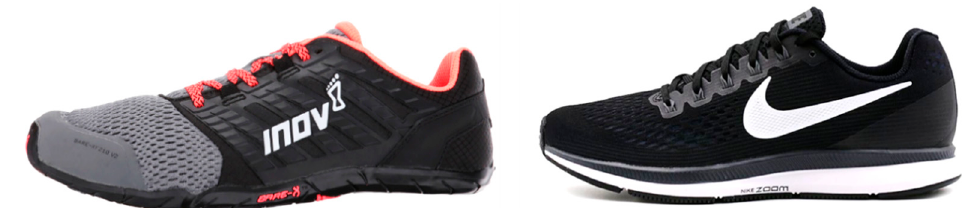
Figure 1. Shoes used in the experiment. Minimalist shoe: INOV-8 Bare-XF 210 V2 ( left ). Cushioned shoe: Nike Air Zoom Pegasus 34 ( right ). Table 1. Detailed comparison of the Minimalist Index (MI) of the two shoes.